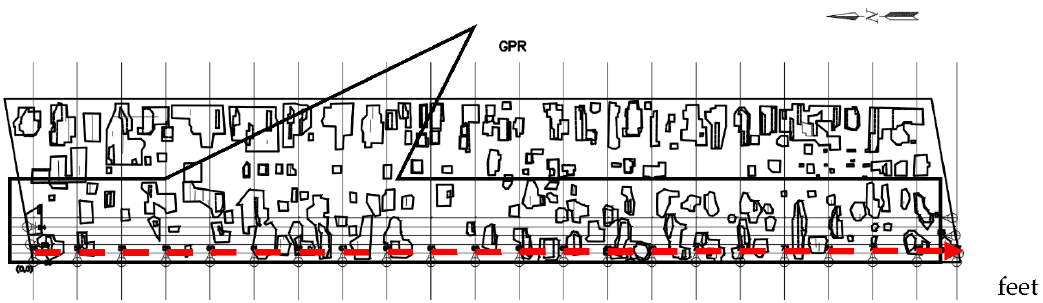
Figure 12. GPR scan signal line 51 from CAD layout for FR NB.